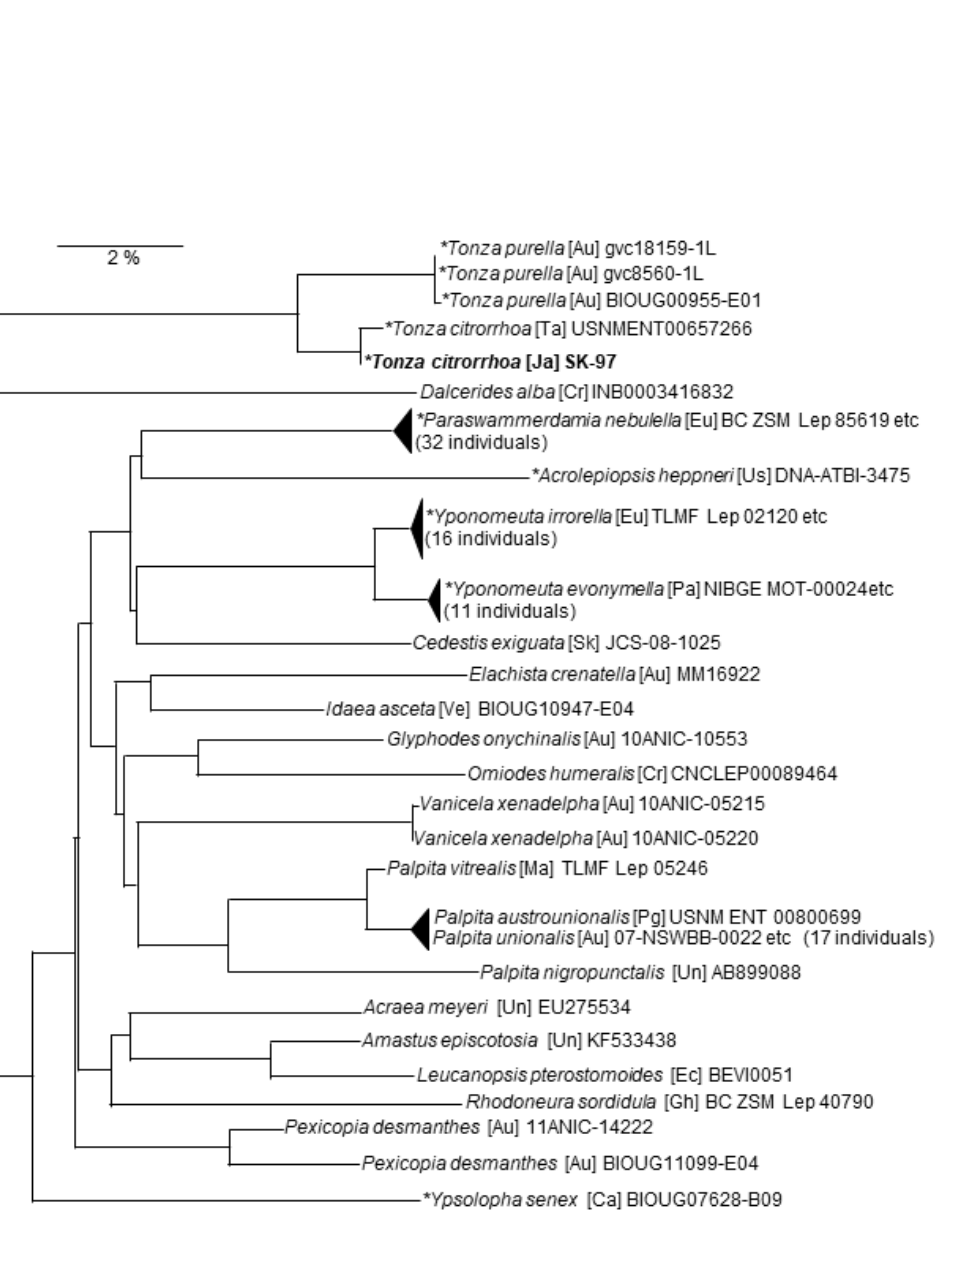
Fig. 2. A tree estimated by neighbor-joining analysis under Kimura’s two-parameter distance model using DNA barcode sequence, retrieved from BOLD identification system (IDS). Branch lengths are proportional to distances. Sequence with ID started from “SK-” is obtained from the present study, and the others are from the BOLD database. The letters within square brackets refer to the collection site of specimens as follows: Au = Australia; Ca = Canada; Cr = Costa Rica; Ec = Ecuador; Eu = Europe; Gh = Ghana; Ja = Japan; Ma = Macedonia; Pa = Pakistan; Pg = Papua New Guinea; Sk = South Korea; Ta = Taiwan; Un = Unknown; Us = United States; Ve = Venezuela. Asterisks show the superfamily Ypono-